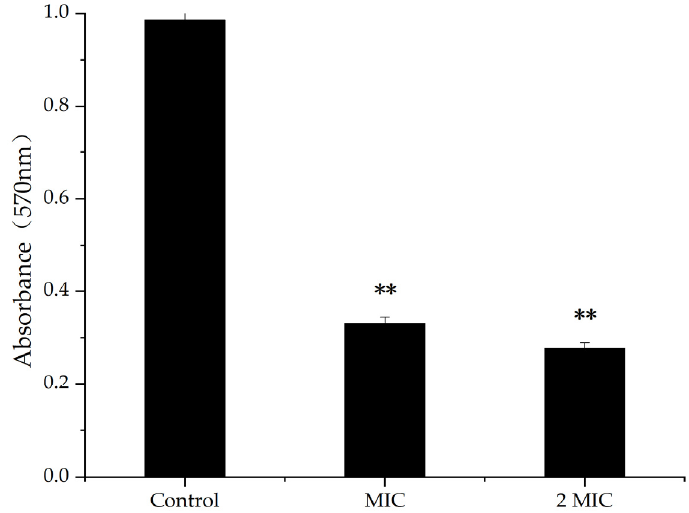
Figure 2. Inhibition of MA on biofilm; **: Compared with the control group, the difference is extremely significant ( p < 0.01).